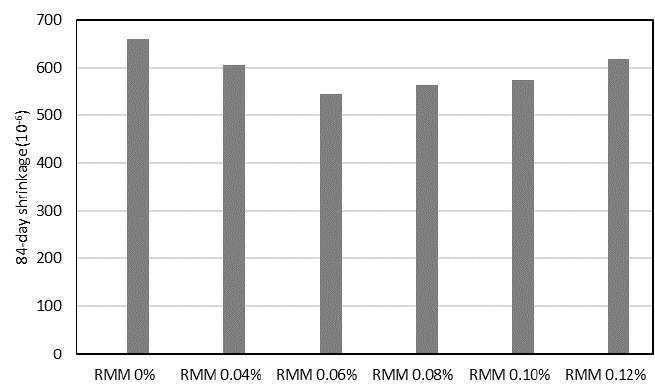
Figure 5. The influence of fiber volume fraction on the 84-day shrinkage.